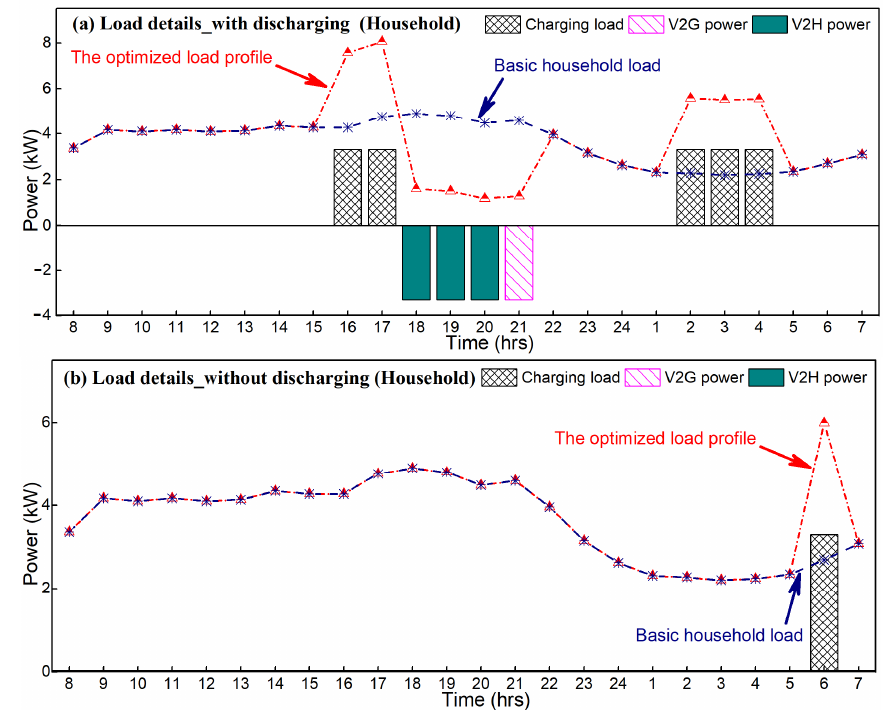
Figure 10. Outcome for the EV management of the household: ( a ) load details with discharging; ( b ) load details without discharging; basic household load refers to the household load without EV load profile; the optimized load profile refers to the basic household load plus the aggregated EV charging/discharging result based on the proposed model.